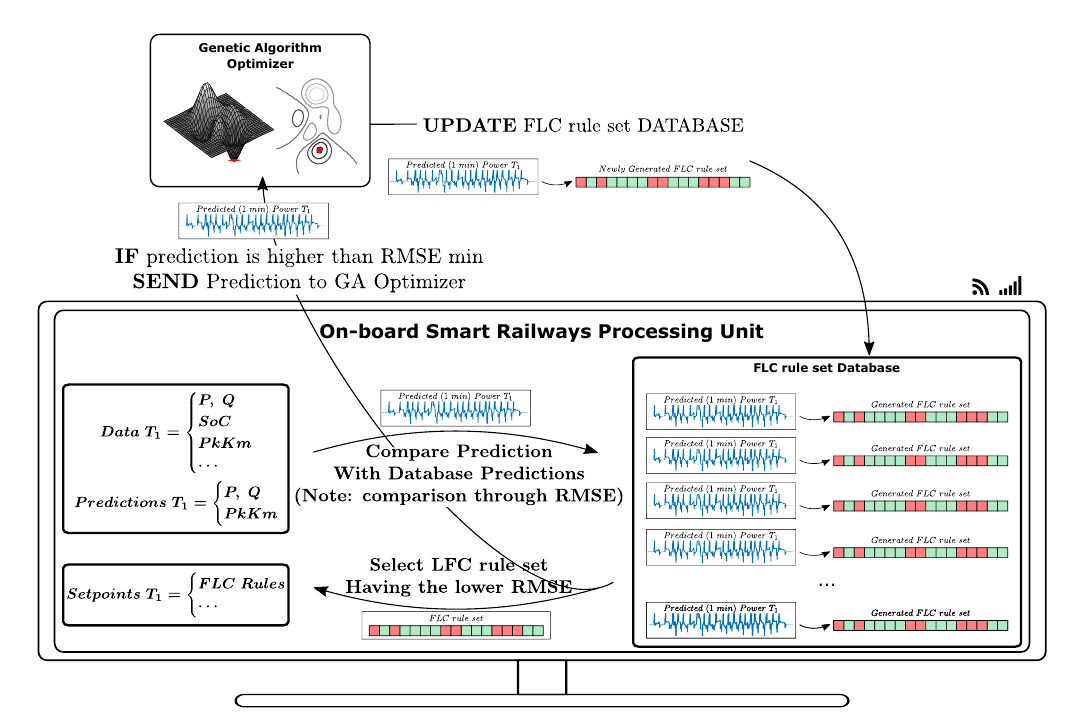
Figure 16. Strategy for real-time operation of on-board smart railways processing